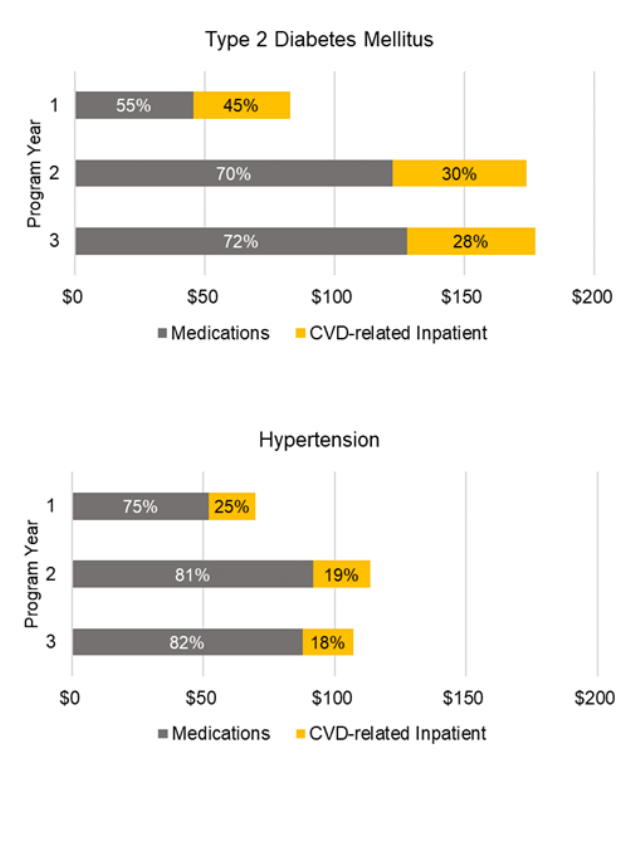
Figure 2. Base case health resource use savings and contributions to estimated savings. Cost estimates are per enrollee per month in year 1 dollars by patient